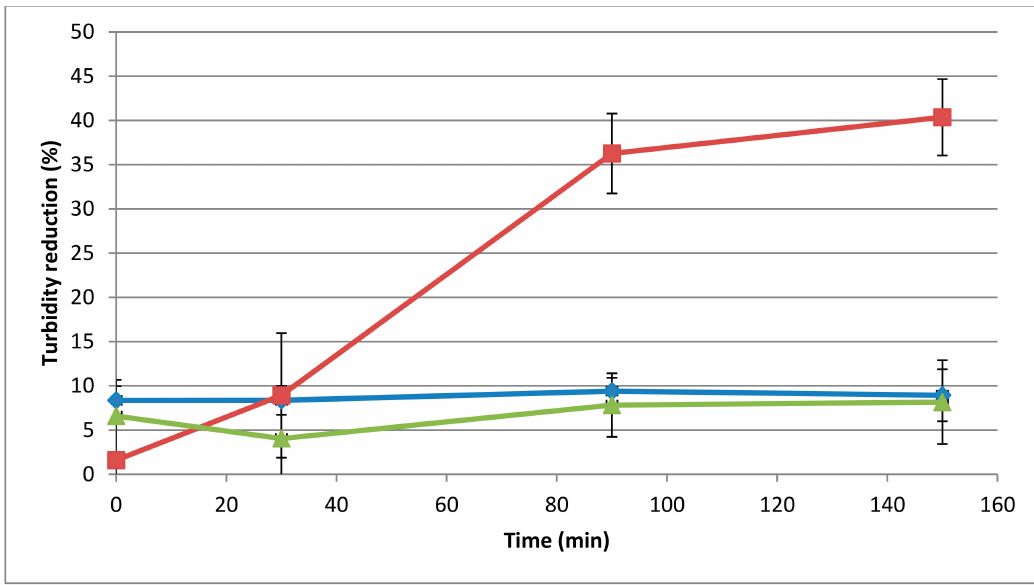
Figure 2. Influence of temperature on the lytic activity of the 293-amidase (40 µ g / mL) against autoclaved L. monocytogenes 473. Lytic activity datasets are represented as in Figure 1. Di ff erent line colours are di ff erent temperatures: blue, 25 ◦ C; red, 37 ◦ C; green, 50 ◦ C.